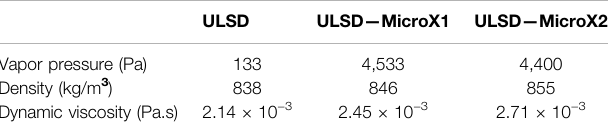
TABLE 1 | Fuel properties of ULSD and the two alternative diesel fuels. Vapor pressure and density were measured at 25 C, while dynamic viscosity was measured at 40